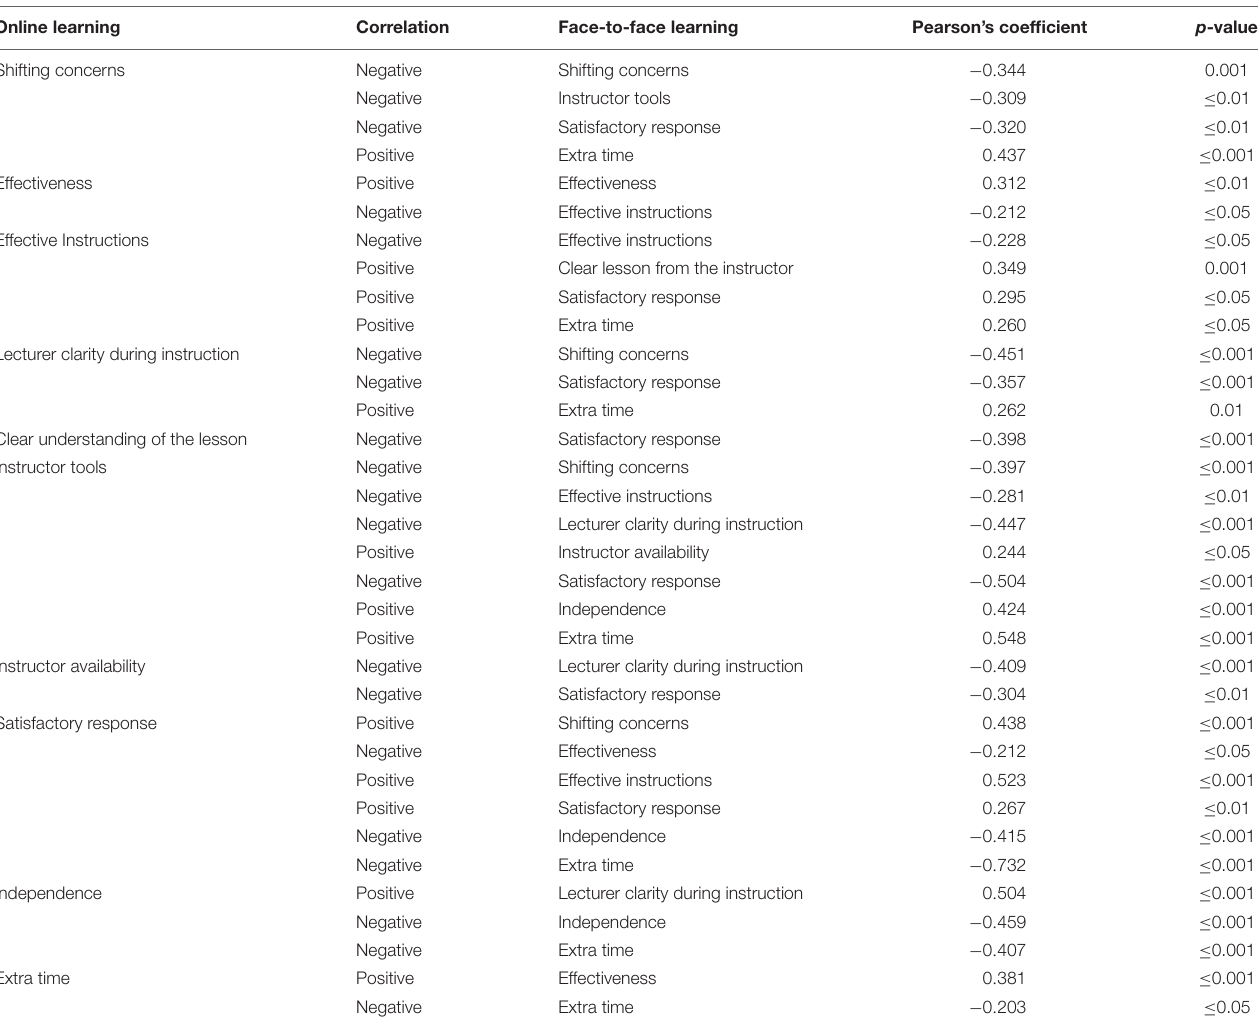
TABLE 7 | Significant correlation between online and face-to-face learning according to different parameters.